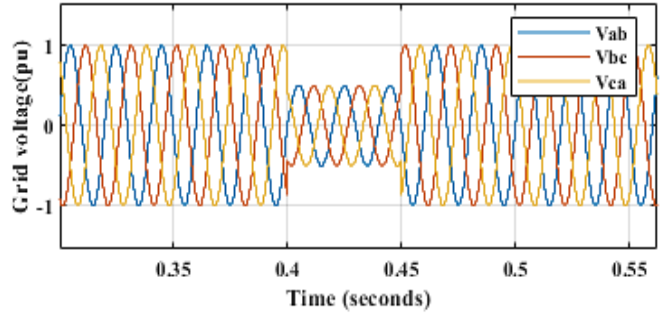
Figure 22. Grid voltage of the DFIG system under scenario III.